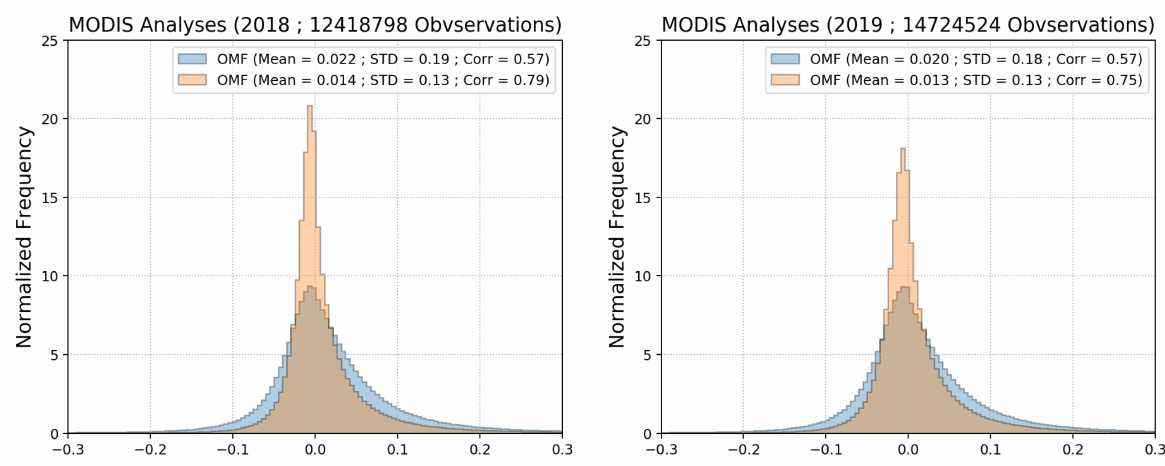
Figure 1. OMF (observation minus forecast) and OMA (observation minus analysis) assimilation diagnostics for the two years of functioning of the pre-operational system 2018 and 2019. Other statistics between the MODIS AOD observations and the forecasts on one hand, and between the MODIS AOD observations and the analyses in terms of correlation, bias and root mean square error (RMSE) are presented in Table